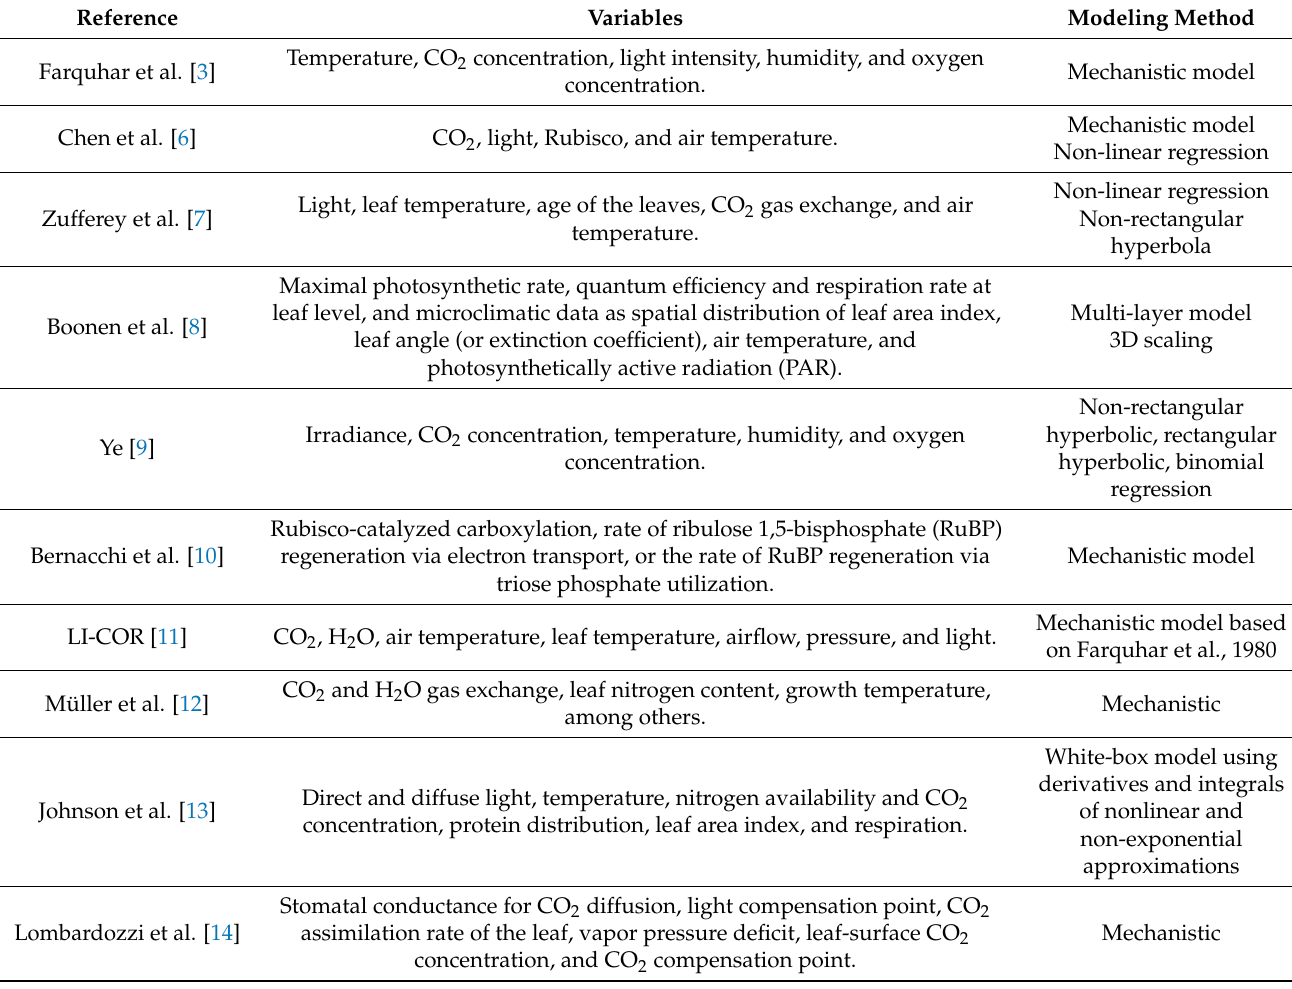
Table 1. Variables and mathematical models’ strategies of previous photosynthesis